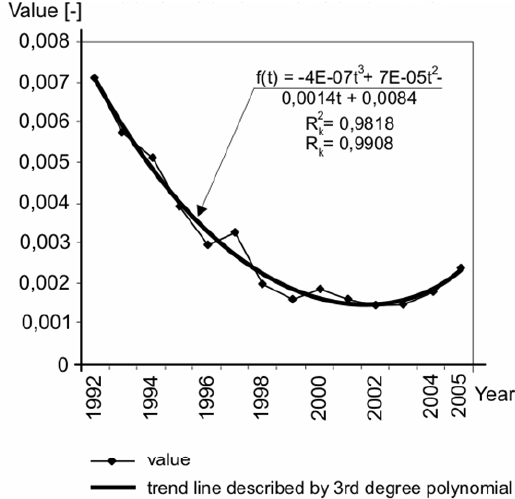
Fig 6. Fatal accident rate index per construction produc- tion value of 1 M in 1992–2005